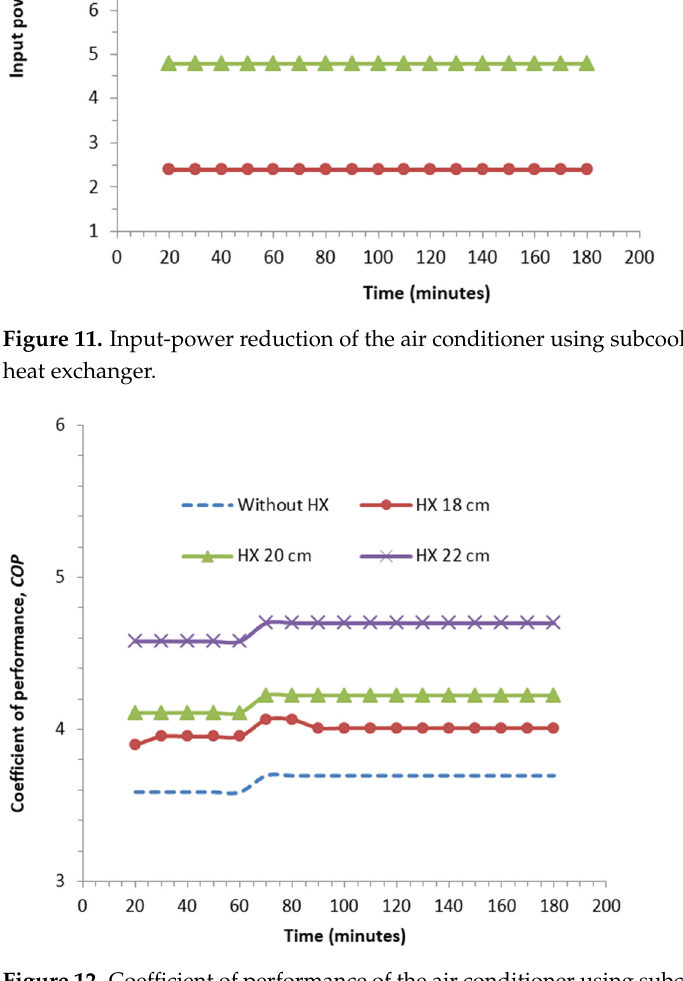
Figure 11. Input-power reduction of the air conditioner using subcooler for three different lengths of heat exchanger.